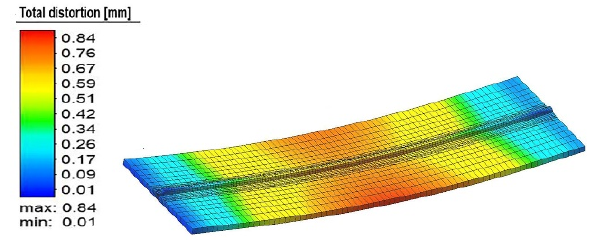
Figure 4. The total distortion in experiment number 3.